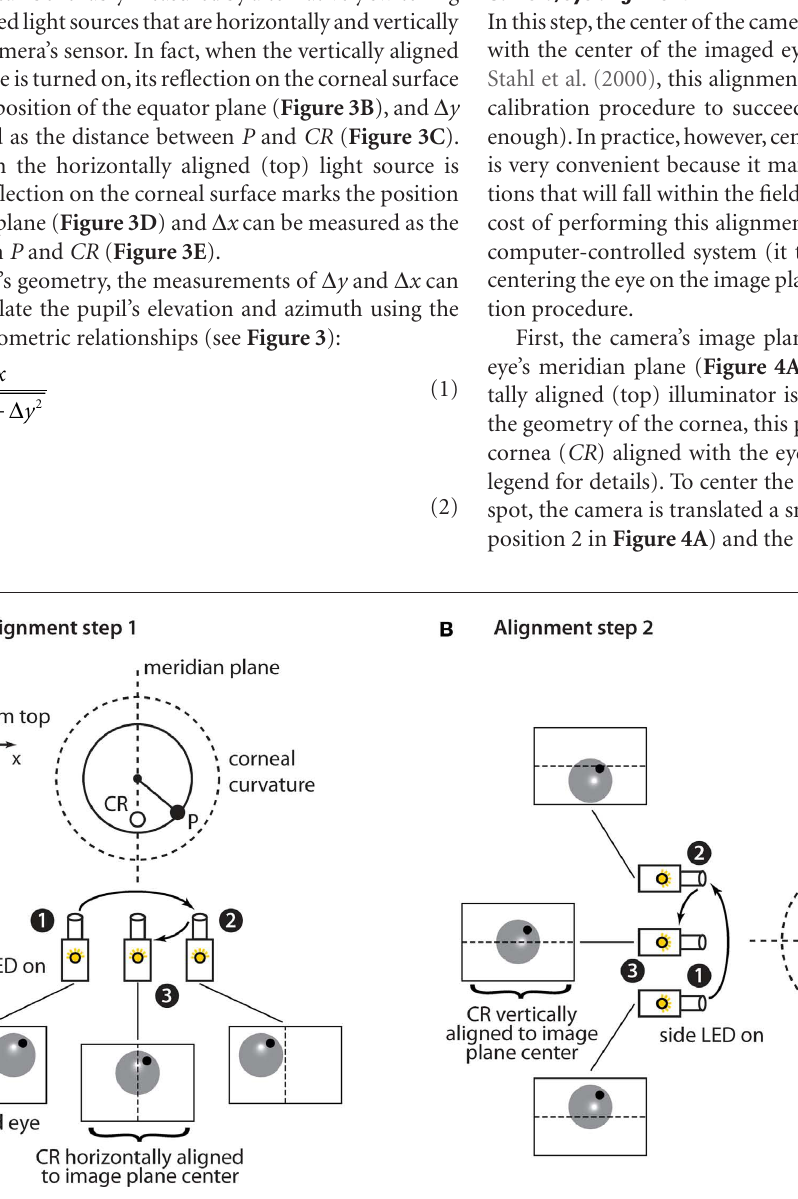
conversion factor and then makes an additional translation (from position 2 to position 3) that aligns the CR with the center of the horizontal axis of the camera’s sensor. Note that because the cornea behaves as a spherical mirror the CR marks the position of the eye’s meridian plane throughout all horizontal displacements of the camera’s assembly (i.e., the position of the empty circle is the same when the camera is in position 1, 2, and 3). (B) A similar procedure to the one described in (A) is used to vertically align the camera’s sensor to the eye’s equator plane. In this case, the vertically aligned (side) infrared LED is turned on so that the CR marks the position of the eye’s equator plane. A similar process is then repeated along the vertical